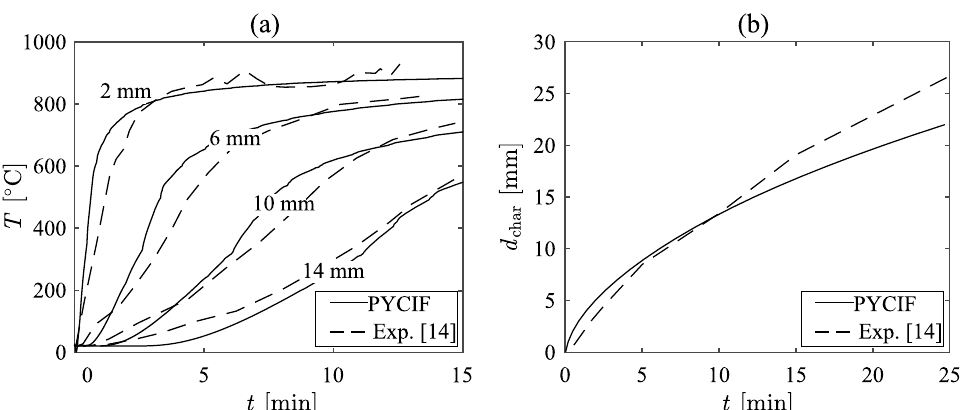
Fig. 10 Comparison of experimental and numerical results for 90 kW/m 2 cone calorimeter test. a The development of temperatures in different points of the specimen. b The development of charring